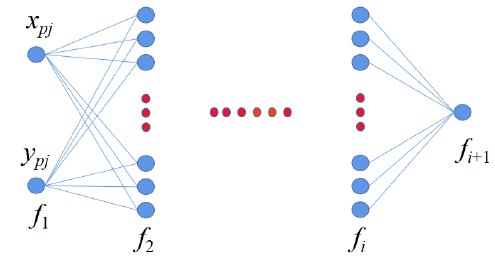
Figure 2. The proposed multi-layer neural network operator (MNNO) takes two-dimensional sam- pling coordinate points as input and outputs sampling